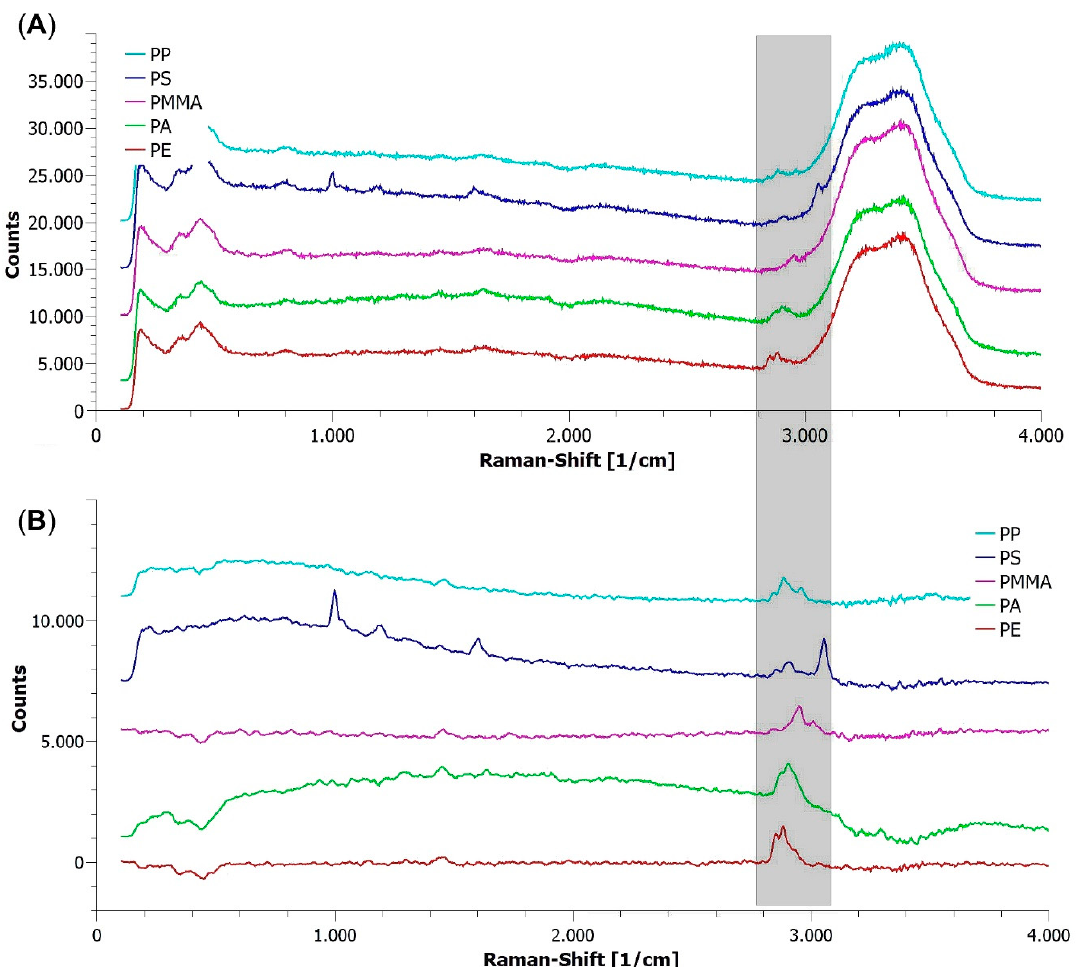
Figure 3. Raman spectra of individual microplastic particles recorded in tap water streaming with 1 L/h through the flow cell: ( A ) as recorded; ( B ) after background removal and smoothing. The shaded spectral range contains the Raman lines used for identifying polymers. Integration time T opt = T eff = 33 ms; beam width within the flow cell: 1 mm; laser power within the flow cell: 1.54 W/mm². The spectra were stacked for visibility.